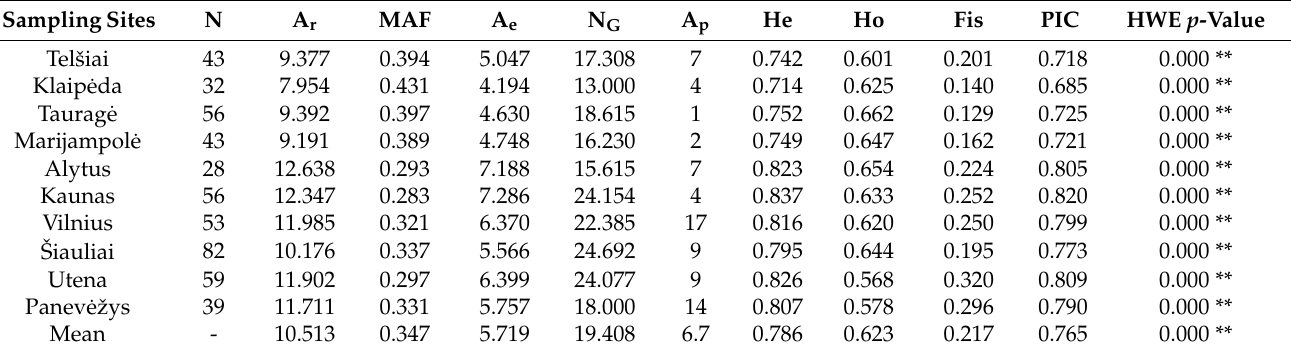
Table 1. Microsatellite diversity and polymorphism of wild boar by sampling